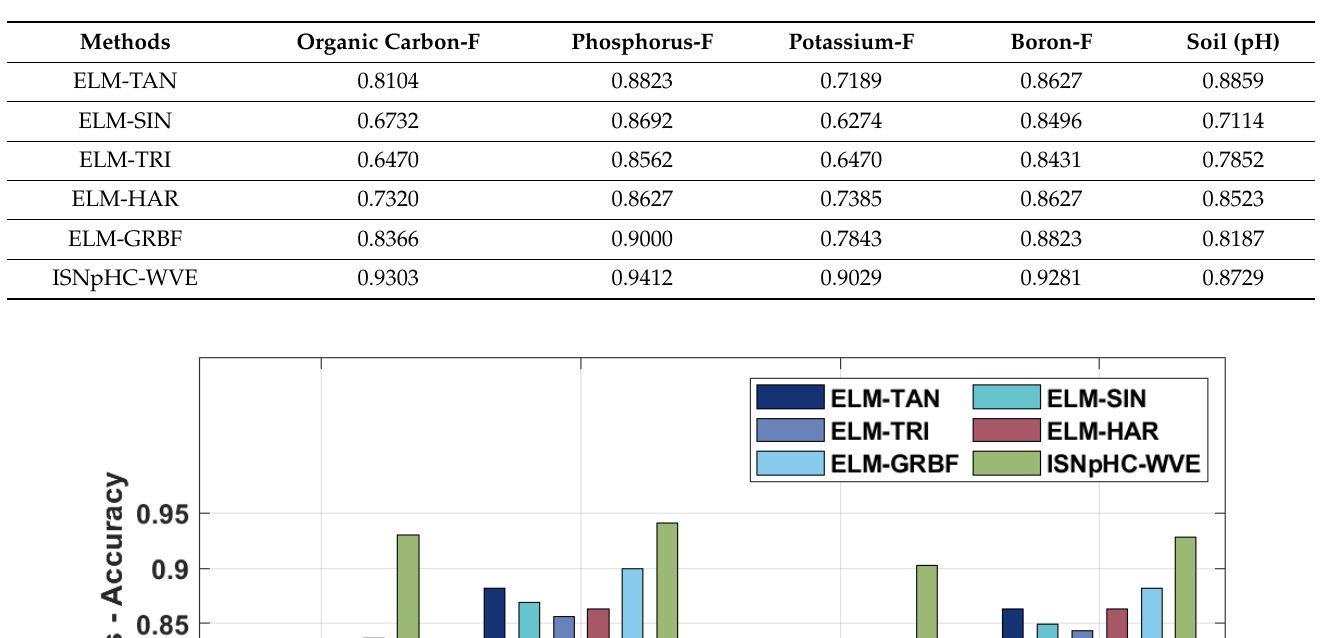
Table 3. Comparative results analysis of the ISNpHC-WVE with existing techniques [10].